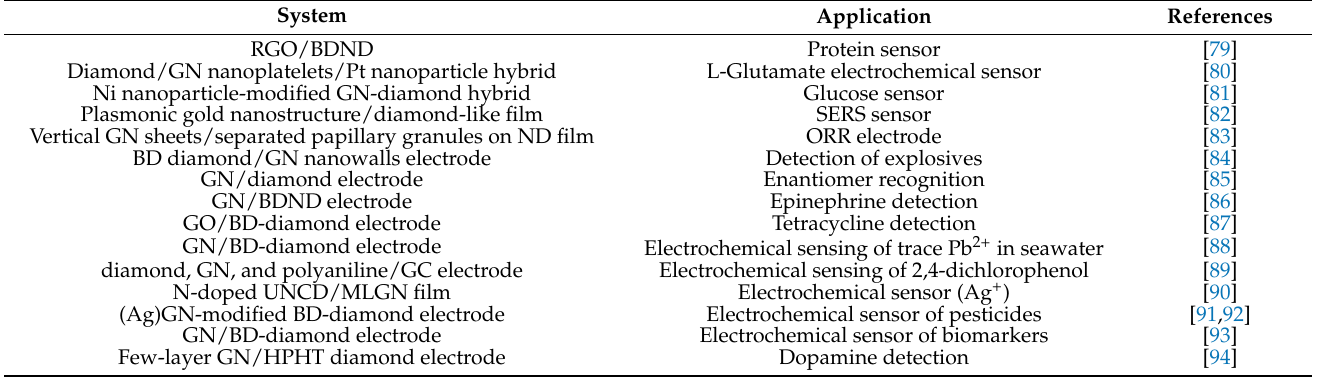
Table 2. Overview of graphene-diamond-based nanomaterials for various sensing applications.